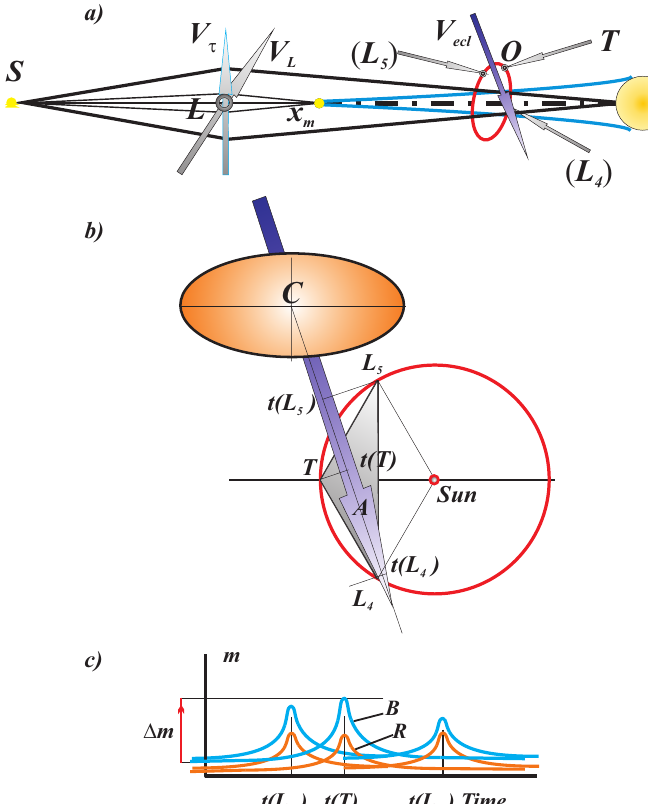
Fig. 4. ( a ): Observations of a transit of an image created by the natural gravity telescope. A massive object L crosses the line “Earth-orbiting observer O – lensed object S ”. The photon flux from object S is focused by the gravity field of object L along the SL line, starting from the minimum distance from the object L , in the x m point, which forms the area of the focused image along the axis. ( b ): The section of the area by the ecliptic plane is a spot with maximum brightness C moving along V ecl . ( c ): Observers in three points L 4, T (Earth), and L 5 detect the rise and fall of brightness m ( t ) in several color bands, accounting for the orbital motion. Placed on the same time scale, the